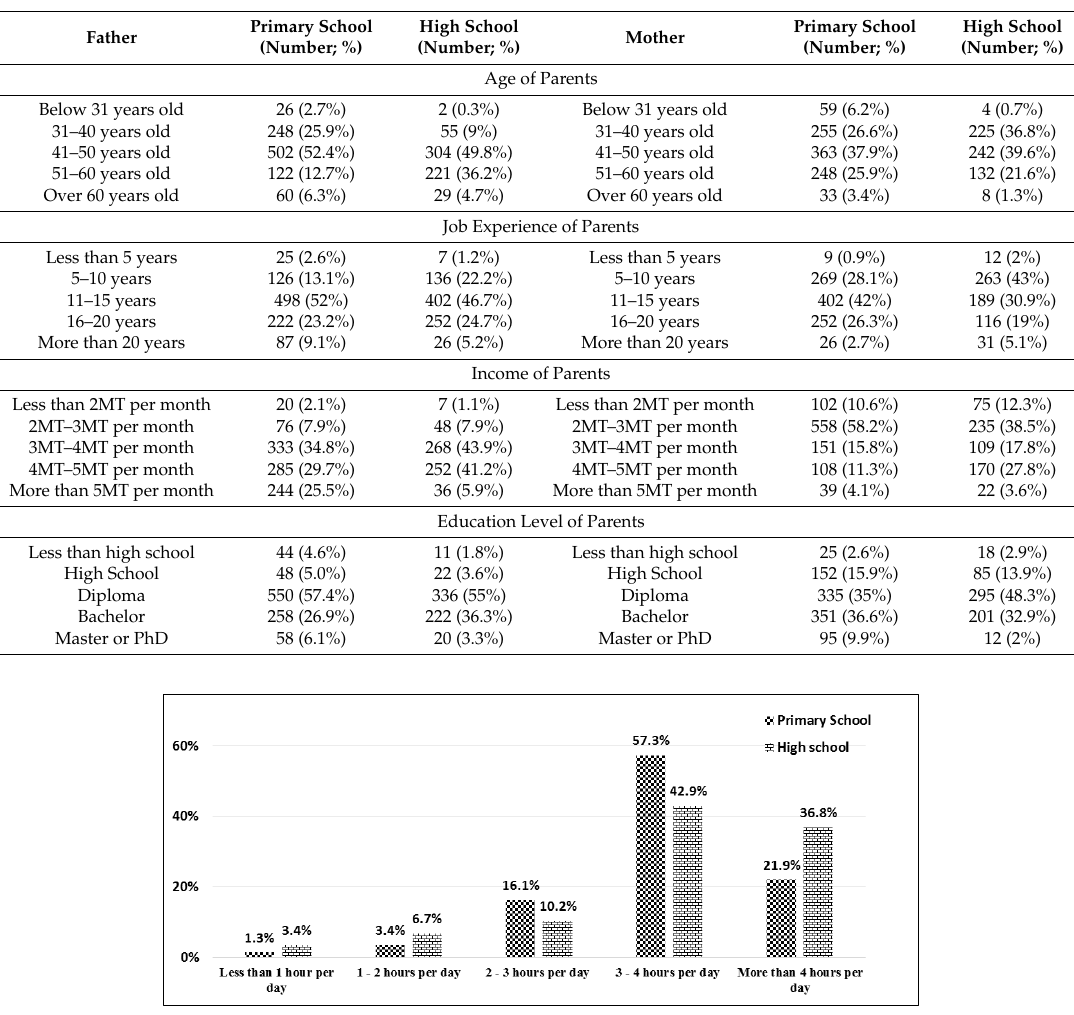
Table 3. Distributions of parents’ characteristics (primary school and high school).